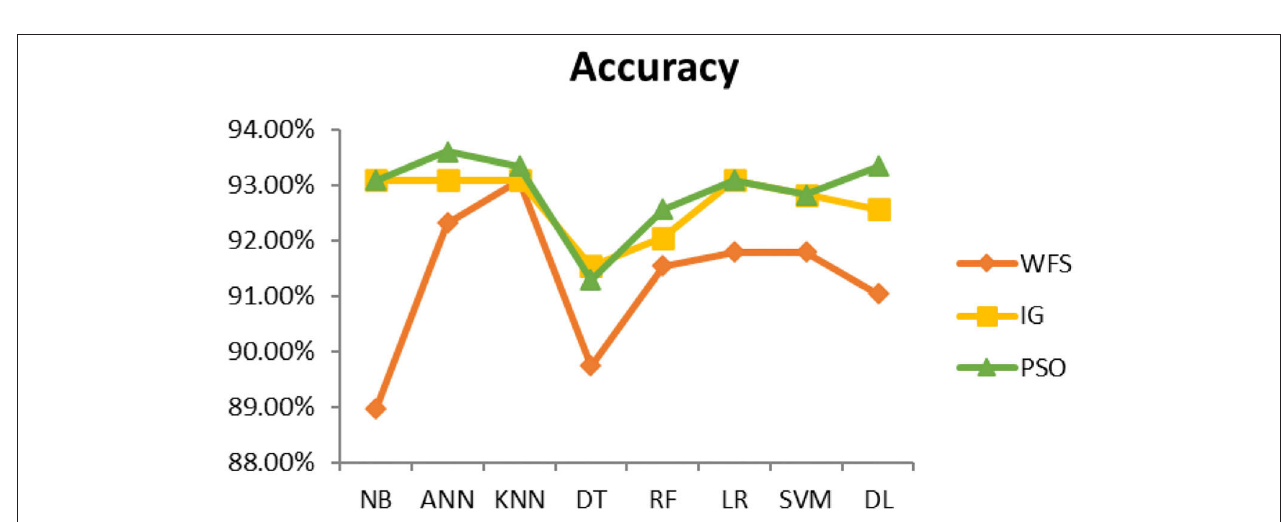
FIGURE 6 | Diabetes diagnosis accuracy (dataset